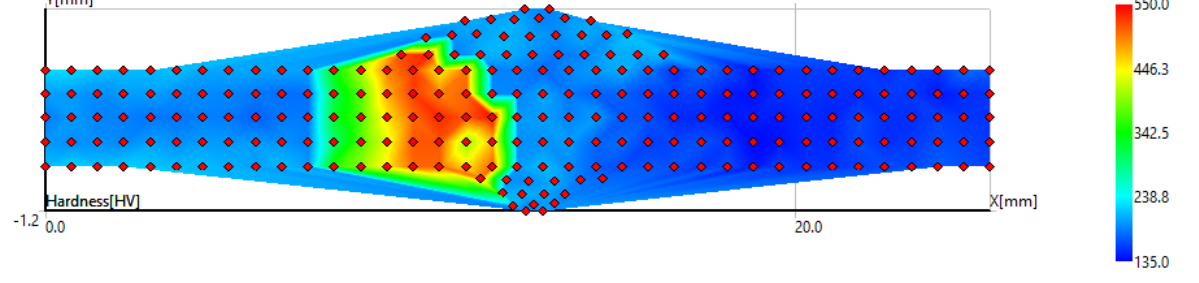
Figure 11. The map of hardness indentations of AISI 420/S355MC dissimilar weld. The martensite was formed when the HAZ close to the FZ was heated above the transformation temperature during welding. Usually, unwanted martensite is consid- ered negative, and its formation indicates inadequate welding procedures. The coarse untempered martensite was observed in the HAZ (Figure 12), while the formation of fine martensitic microstructure was revealed in the BM as it is presented in Figure 8a. Moreover, as the temperature decreased at a distance from HAZ, the carbon diffusion decreased as well as the coarsening of precipitation.